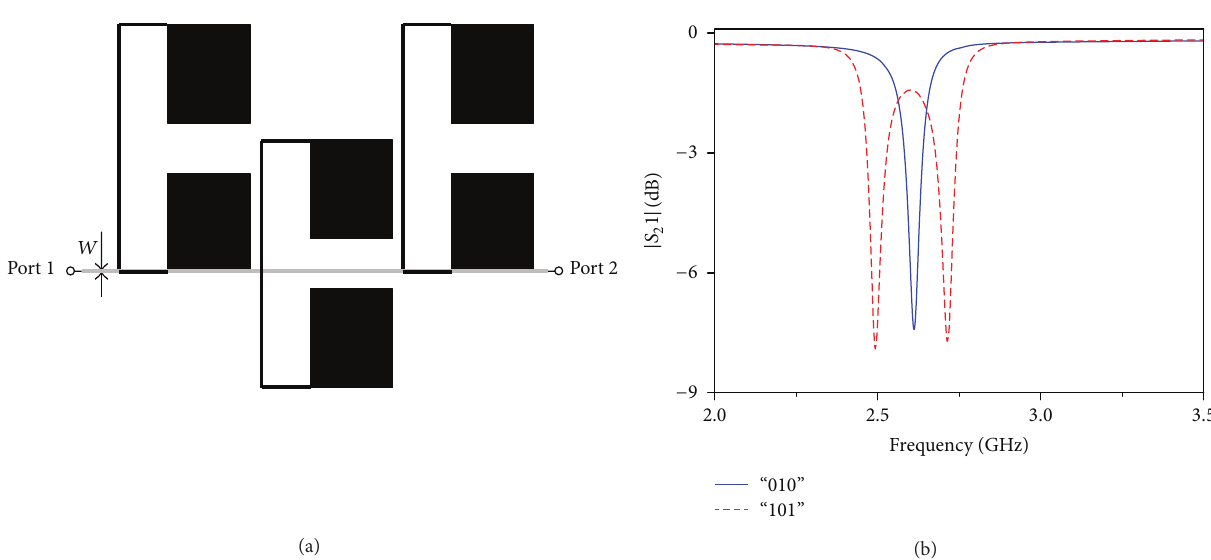
Figure 3: Microstrip line loaded with folded SIRs for the code “101” (a) and lossy electromagnetic simulation of the transmission coefficient corresponding to the indicated codes (b). The top and bottom substrates are Rogers RO3010 with thickness ℎ = 0.254 mm, dielectric constant = 11.2 , and loss tangent tan 𝛿 = 0.0023 . The dimensions are line width 𝑊 = 0.2 mm, corresponding to a characteristic impedance close to 𝜀 𝑟 50 Ω ; for the folded SIRs, 𝑤 1 (2.5 GHz) = 2mm, 𝑤 1 (2.6 GHz) = 1.8mm, 𝑤 1 (2.7 GHz) = 1.64mm, 𝑤 2 = 0.2 mm, 𝑠 = 1.2 mm, 𝑙 1 (2.5 GHz) =